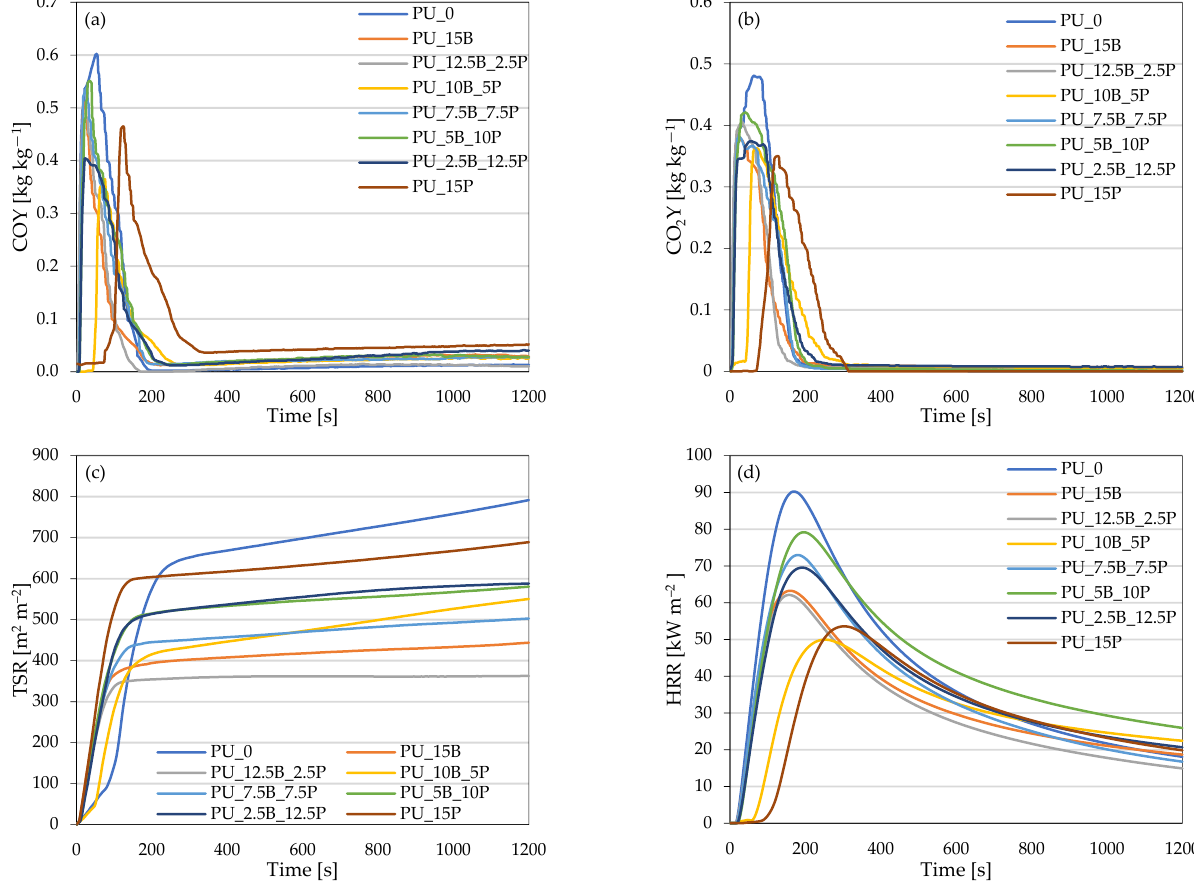
Figure 11. The results of ( a ) an average yield of CO, ( b ) an average yield of CO 2 , ( c ) total smoke release, and ( d ) peak of heat release rate.